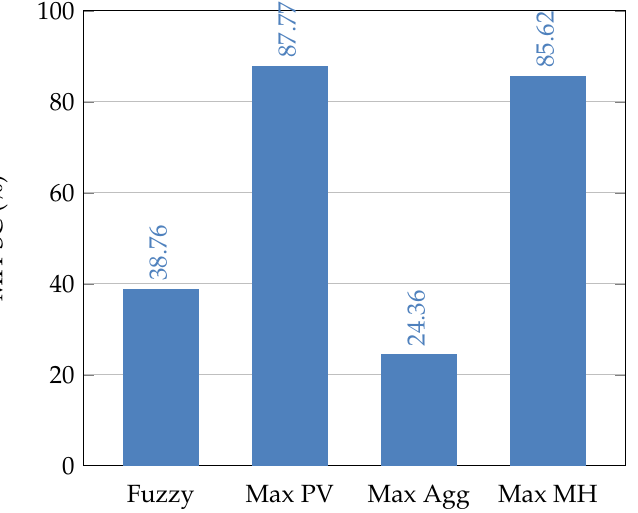
Figure 7. Multi-Household Self-Consumption (MH-SC) for the different decision maker